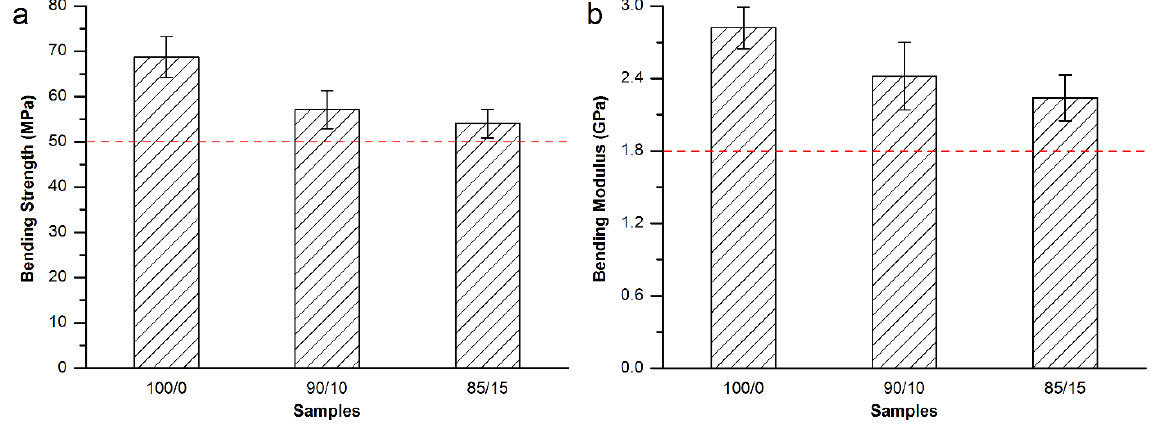
Figure 4. ( a ) Bending strength and ( b ) bending modulus of the MC modified Osteopal ® V bone